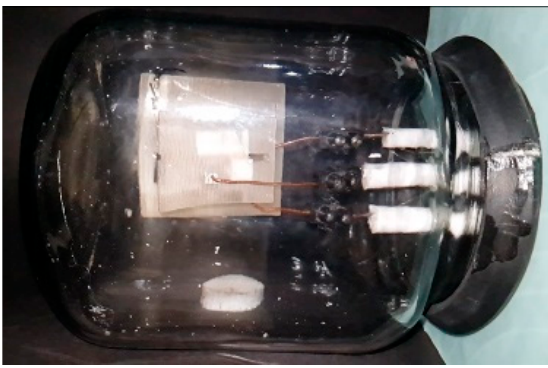
Figure 13. Micro-pendulum Test Stand inside the vacuum chamber.